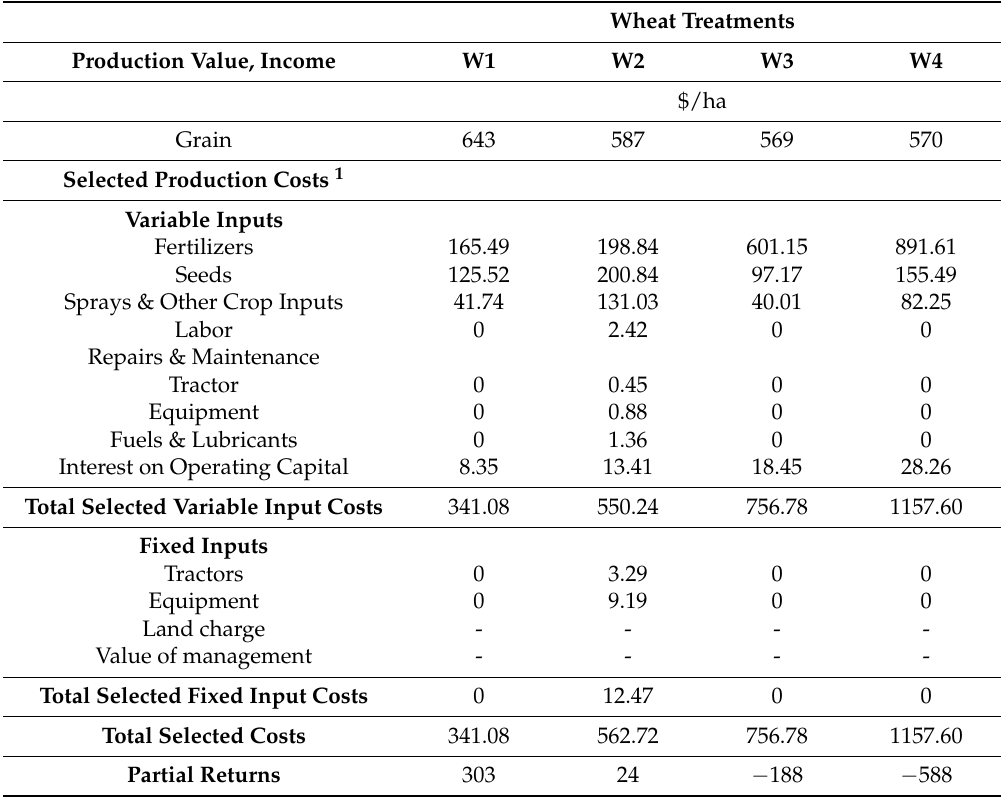
Table 9. Income, selected costs, and partial returns for conventional wheat with recommended management (W1) and high input management (W2), and organic wheat with